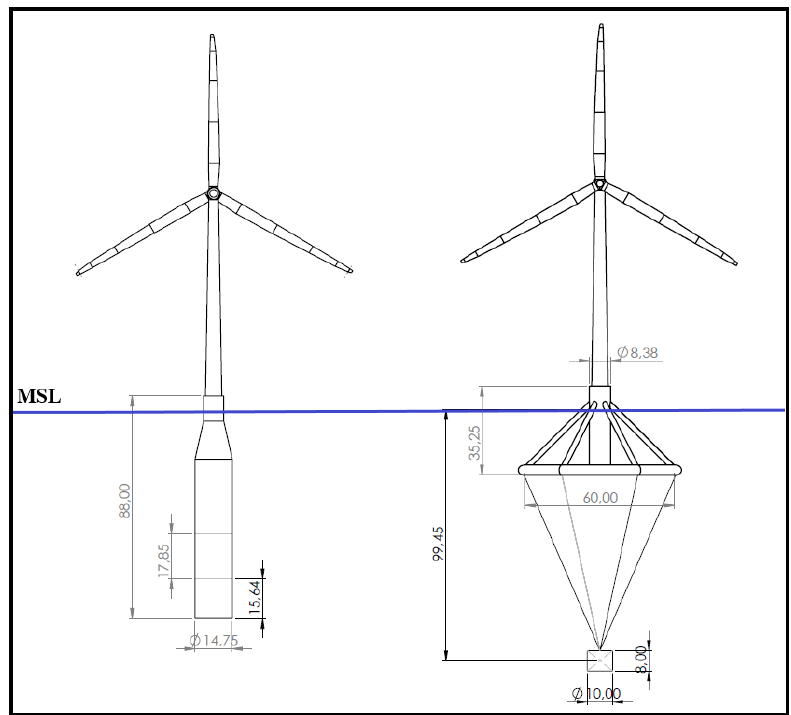
Figure 13. Cad representation of spar-buoy and Hexafloat design.